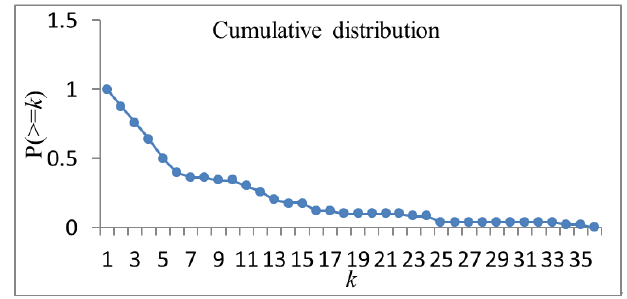
Figure 3. Cumulative distribution of the co-occurrence network of high-frequency words.